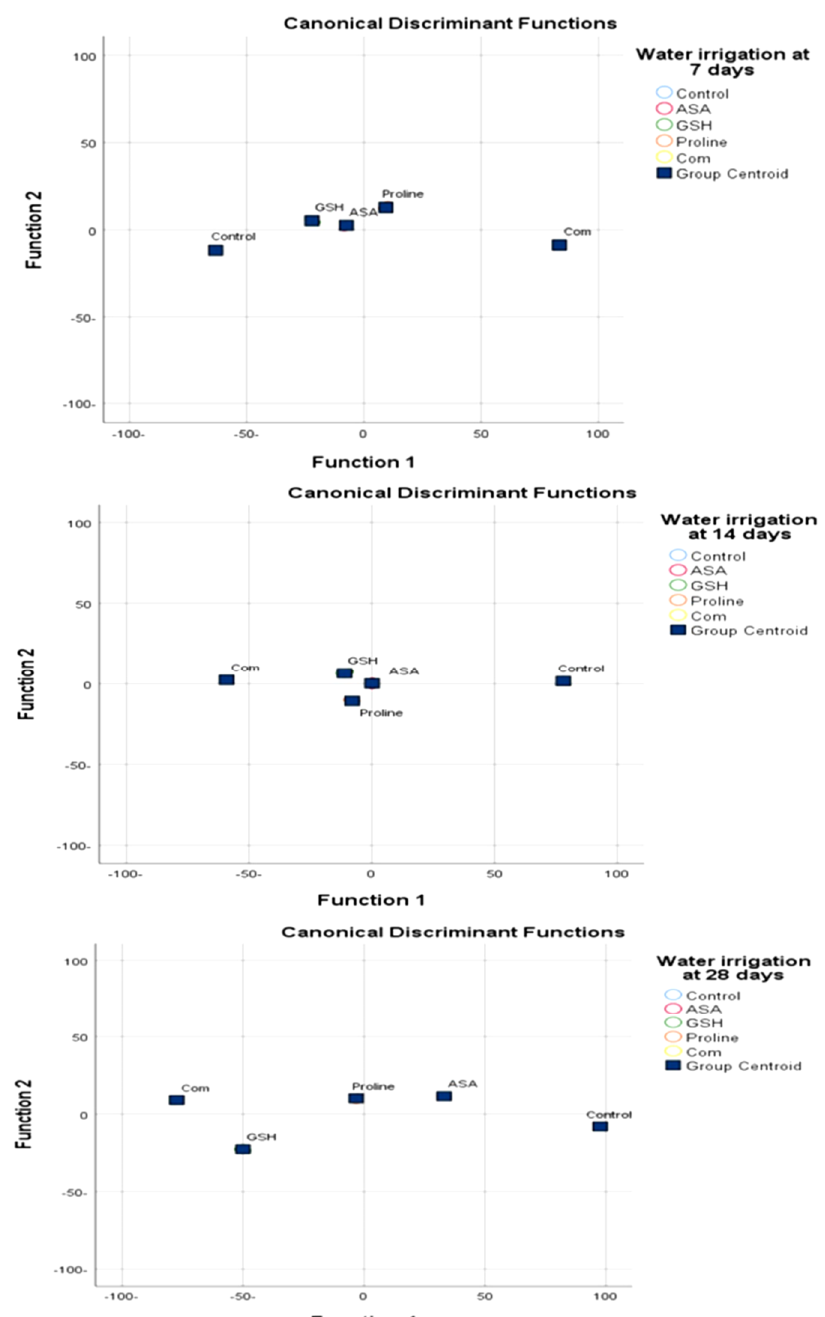
Figure 4. Discriminant functions show the response of AsA, GSH, Pro and sequence combination and di ff erent levels of irrigation interval in chickpea plant.